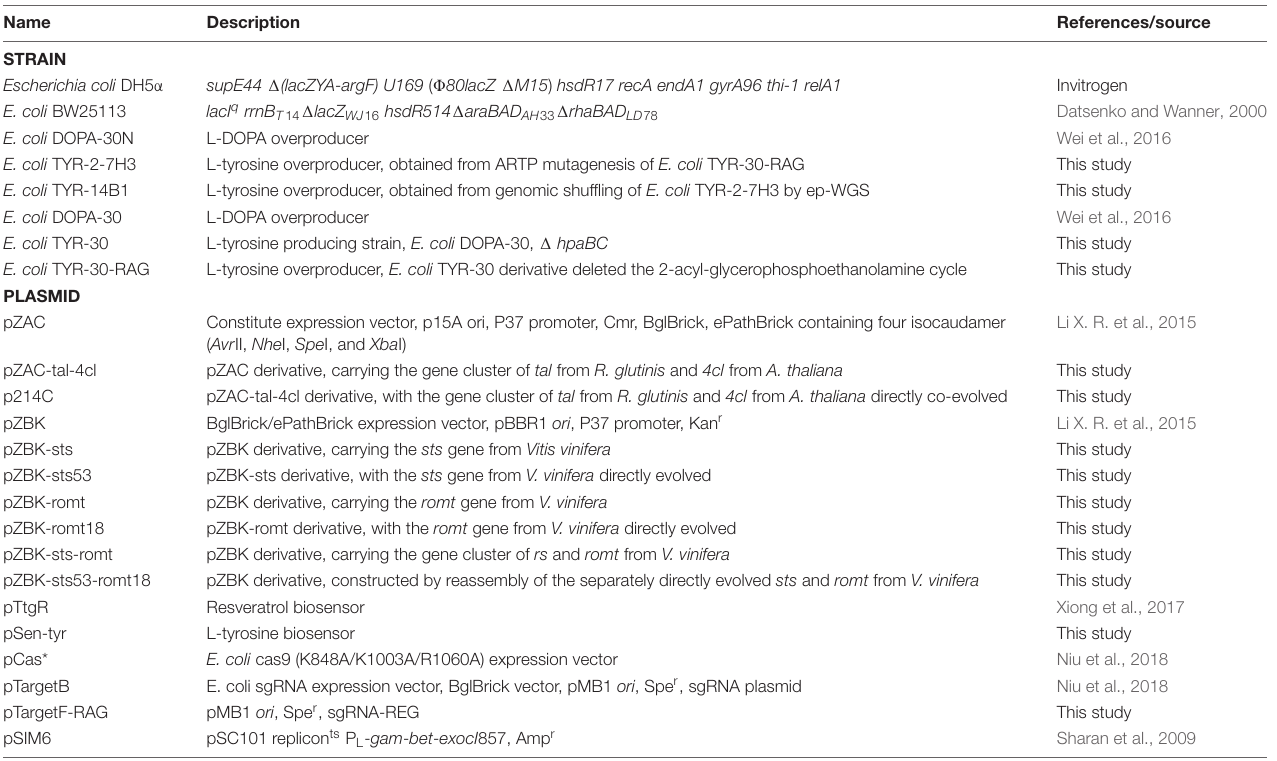
TABLE 1 | Strains and plasmids used in this